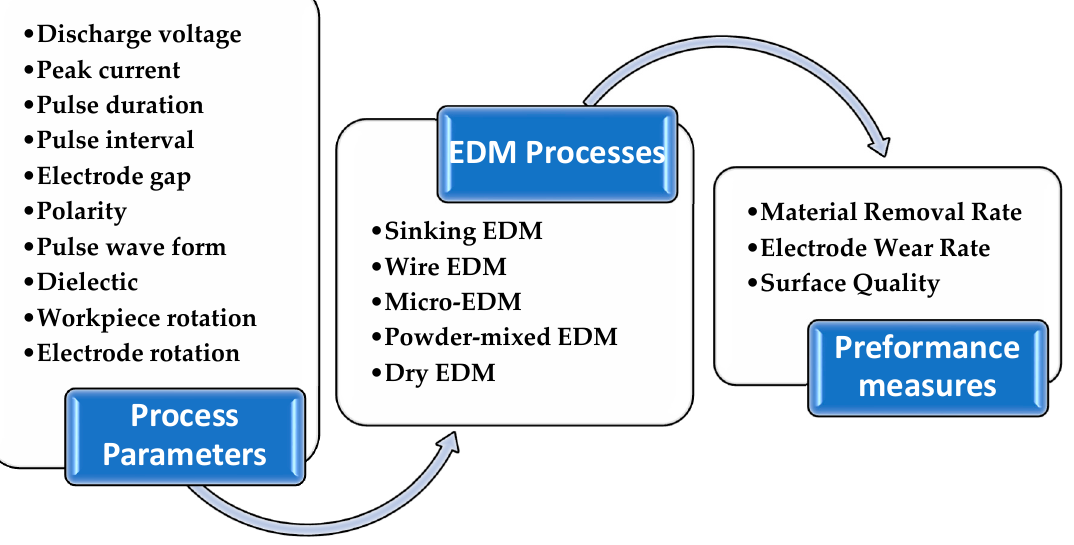
Figure 1. The processes of electric discharge machining (EDM) and their process parameters and performance measures.